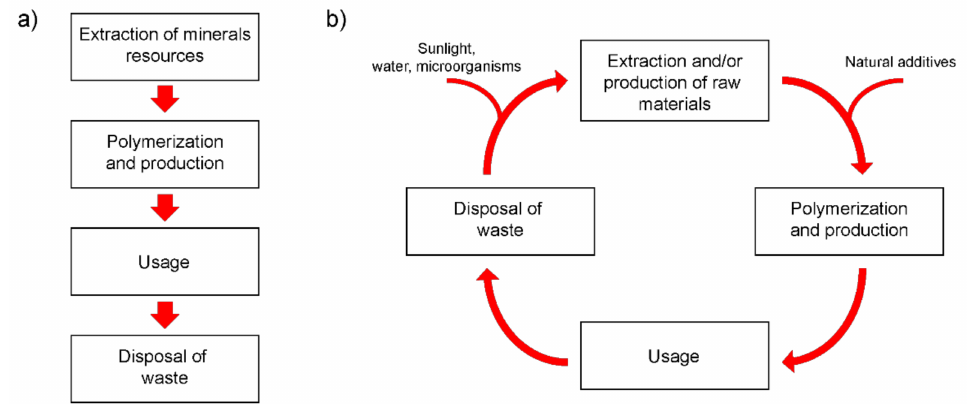
Figure 1. ( a ) Stages of life cycle of polymeric materials. Cycle begins with extraction of fossil resources and ends with accumulation and, possibly, partial processing of polymer waste. ( b ) Expected life cycle of biodegradable polymer materials. At end of their service life, polymers decompose into simple chemical structures due to vital activity of bacteria. Further, decomposition products can be used to produce new